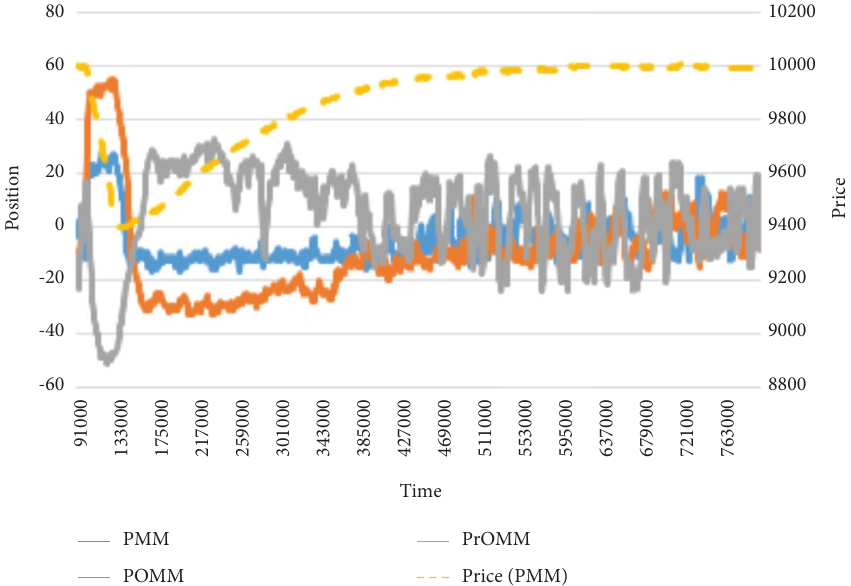
Figure 5: Positions of HFT agents and price transitions in the unstable market.